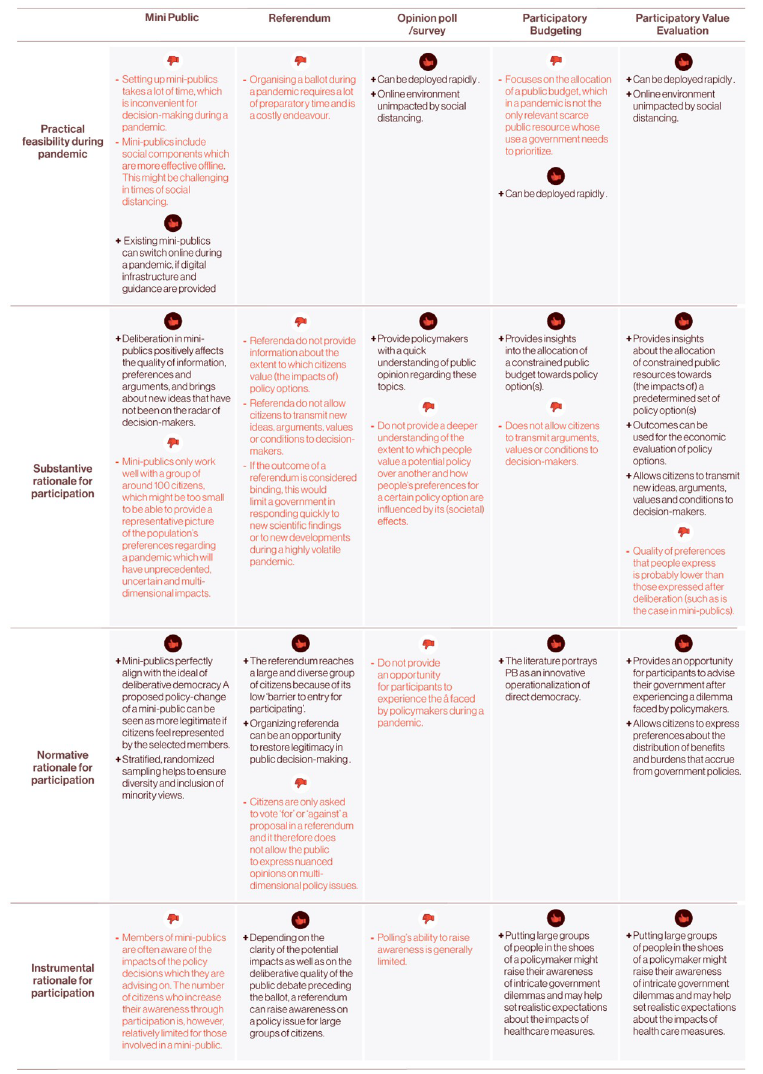
Fig 1. Comparing PVE and other participatory